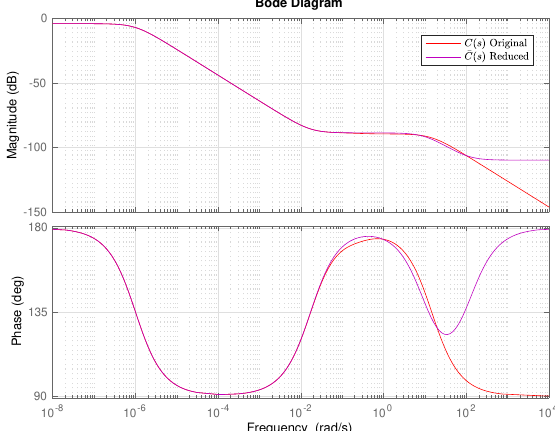
Figure 14. Bode diagram of the original and reduced controller.